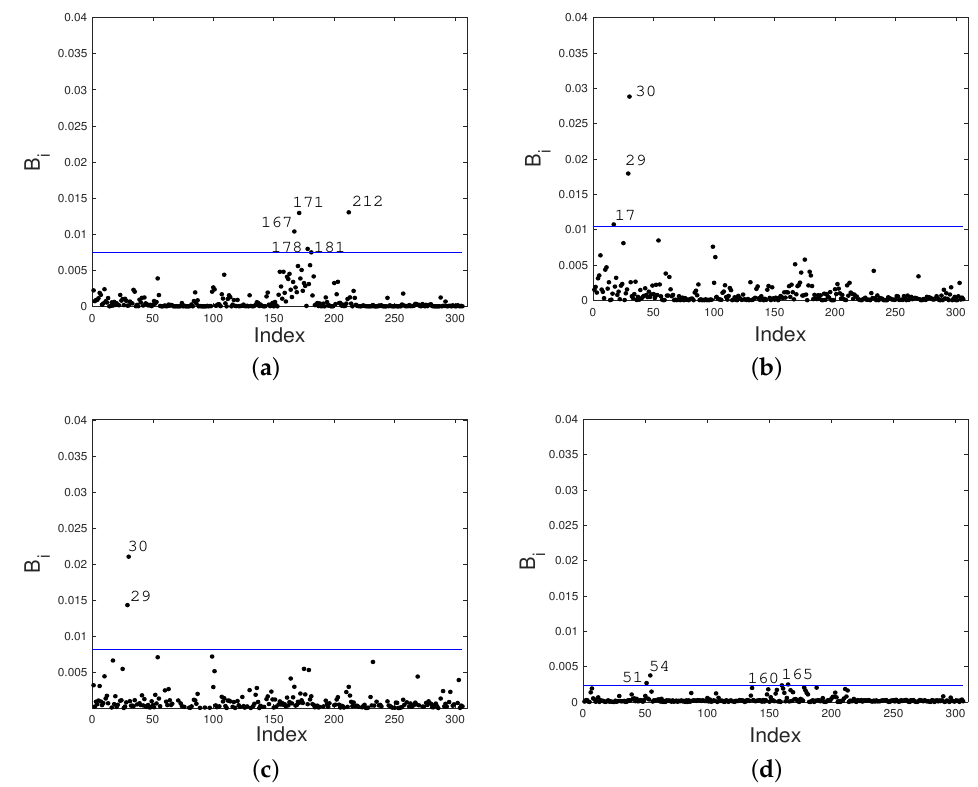
Figure 15. Index plots of B i for assessing local influence on (cid:98) α ( a ); (cid:98) β 1 ( b ); (cid:98) β 2 ( c ); and (cid:98) φ ( d ) under case-weight perturbation for fitted Student-t PVCM (Lima data).